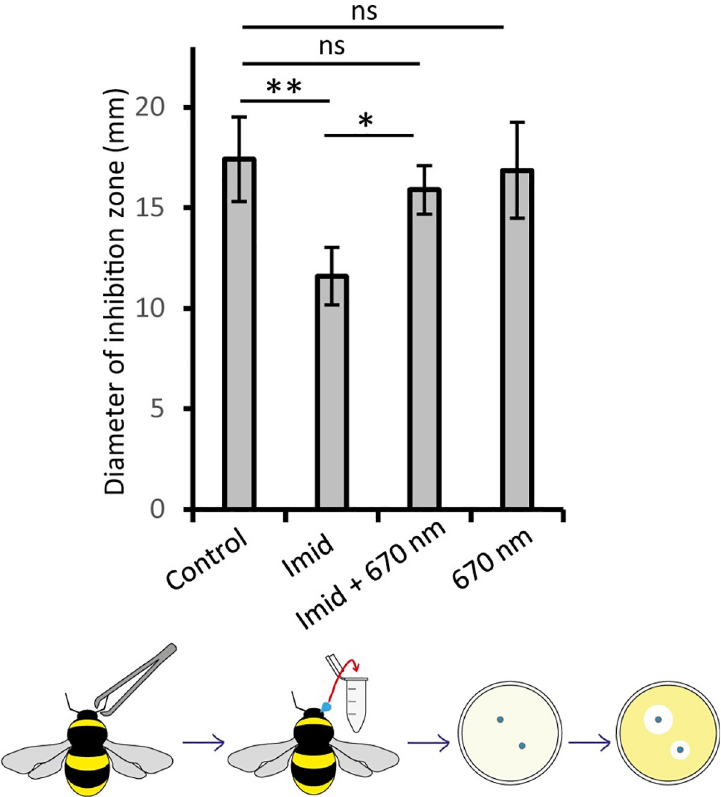
later from antenna base and used in inhibition zone assays as in the schematic. Antimicrobial impact of haemolymph was used as a metric. After E . coli challenge, the haemolymph inhibited bacterial growth. The immunocompetence of haemolymph is significantly reduced after Imidacloprid exposure and partially restored with 670nm exposure after exposure. Abbreviations: � ; p < 0.05, �� ; p < 0.01, ns; no significance, Imid; Imidacloprid. Bumblebees, � 17 bees per